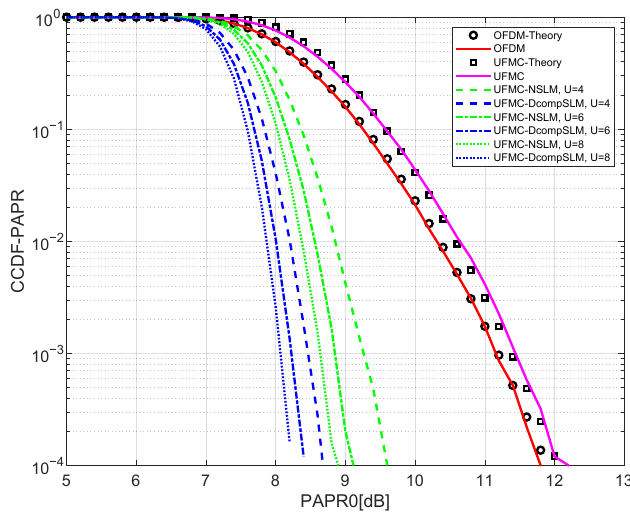
Figure 4. CCDF-PAPR of UFMC format and OFDM with N = 512 and 16-QAM modulation, at different number of phase vectors, U = 4, 6, and 8 for both NSLM and Dcomp-SLM schemes.